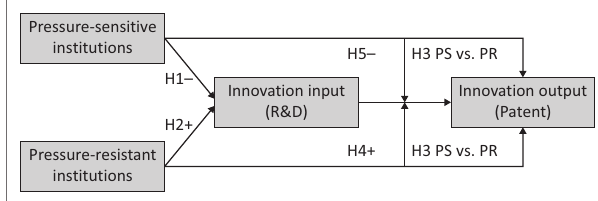
FIGURE 1: Conceptual framework.